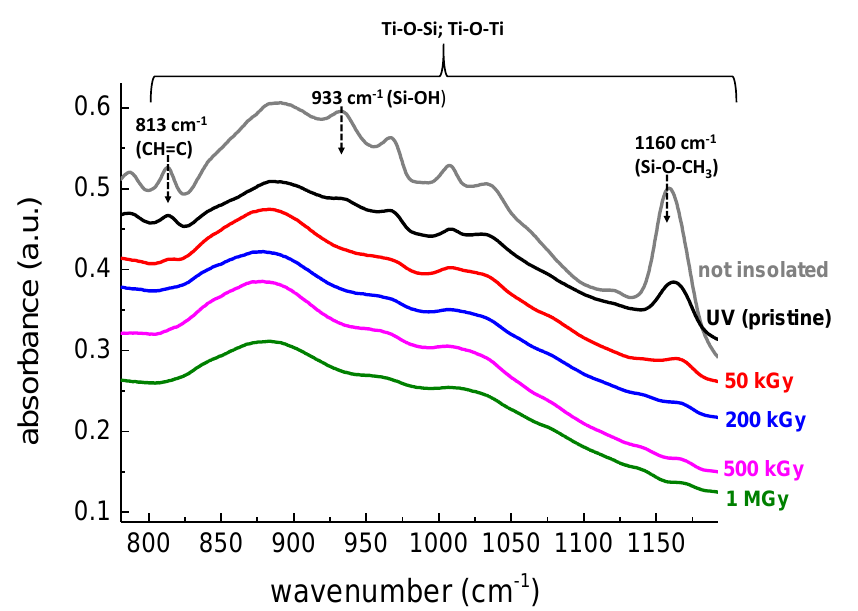
Figure 7. FTIR spectroscopy of organo TiO 2 -SiO 2 films doped with R6G deposited on Si substrate. The graph represents the non-exposed film (grey line), the UV-exposed film (black line) and the samples exposed to γ -rays with different accumulated doses of: 50 kGy (red line), 200 kGy (blue line), 500 kGy (magenta line) and 1 MGy (green line). All the layers exposed to γ -rays were first exposed to UV photons. For better visualization, spectra are vertically shifted.